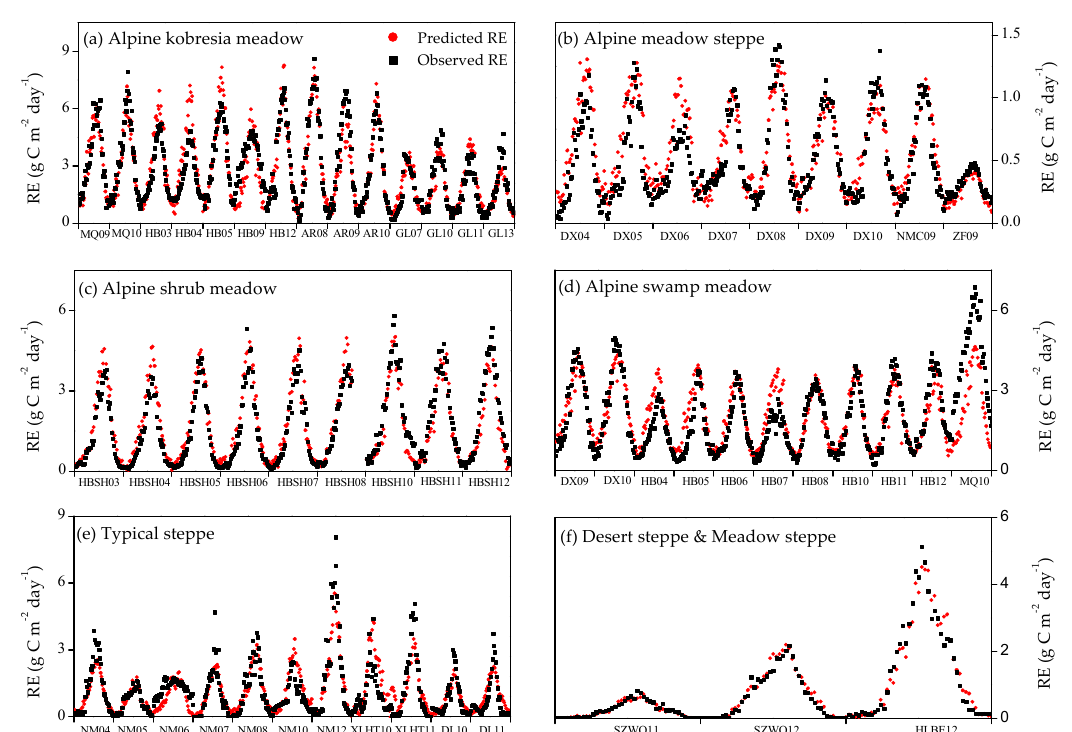
Figure 6. Time-series plots for observed (black square dot) and modeled (red round dot) ecosystem respiration ( RE ) at all sites. The text in the abscissa represents the abbreviation of the site name, and the following number represents the year.